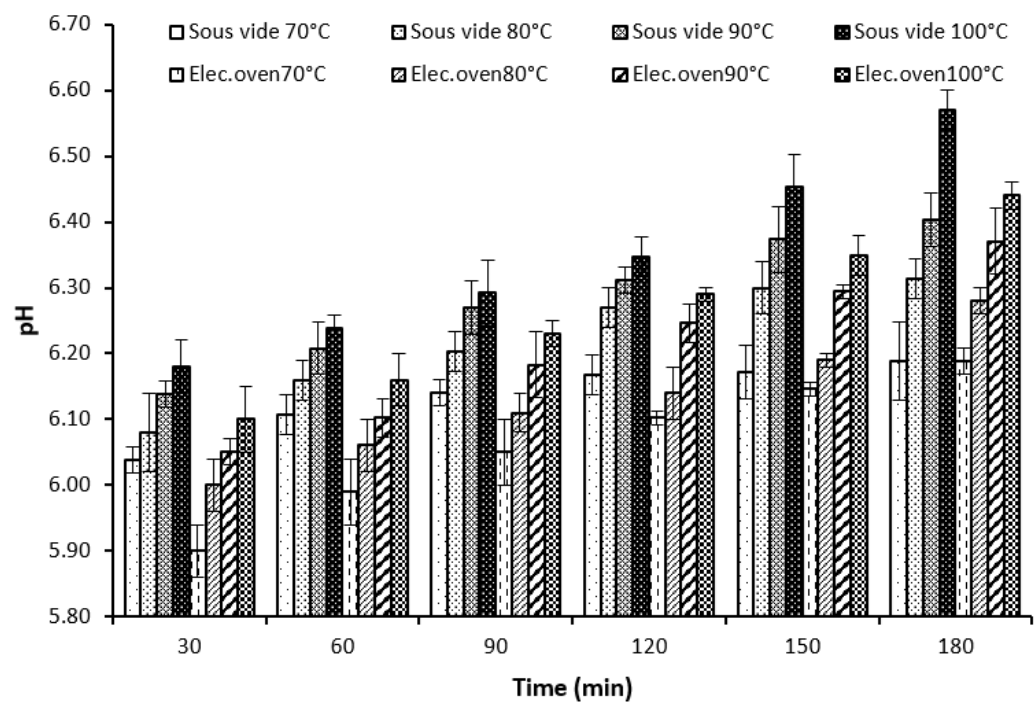
Figure 1. The effect of the cooking method (sous vide vs. electrical oven) on the camel meat physical properties (pH) at different combinations of temperature and time .